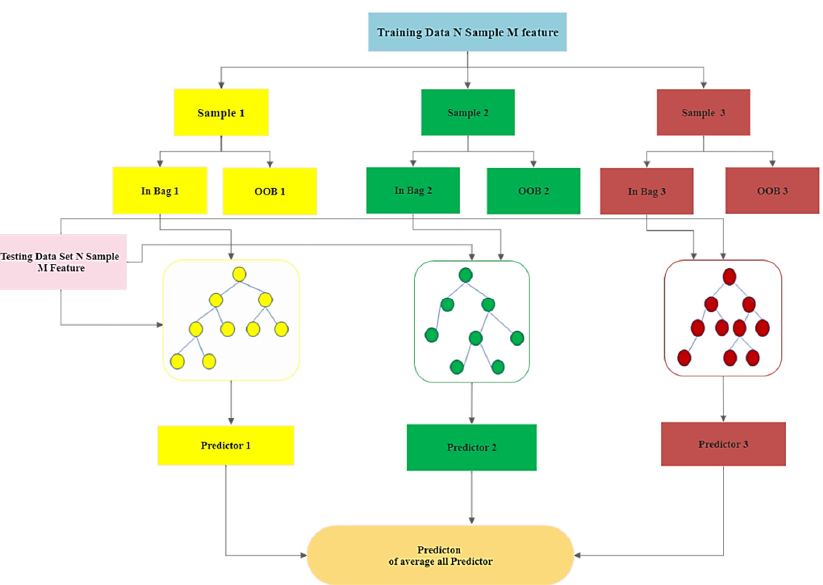
Figure 4. The architecture of the random forest algorithm.